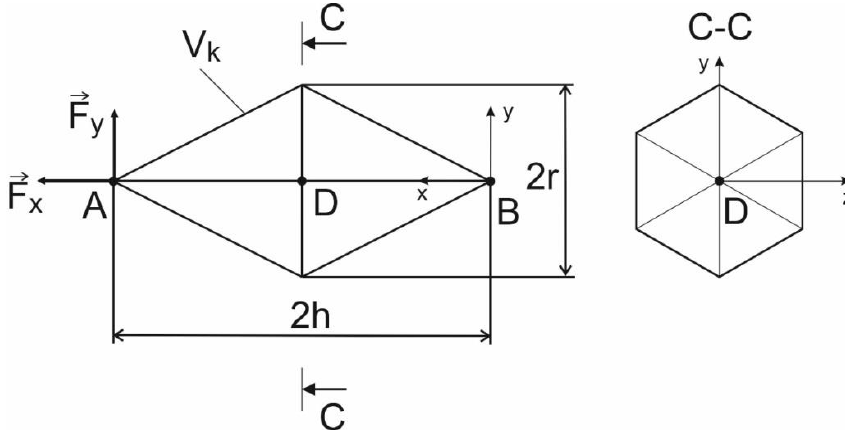
Figure 4. Calculation scheme for a unit cell.